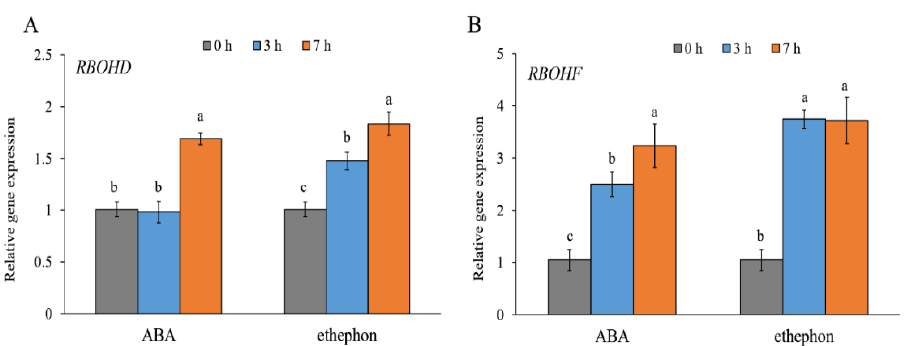
Figure 3. Gene expression patterns of RBOHD ( A ) and RBOHF ( B ) in E. salsugineum leaves sprayed with ABA or ethephon. Data represent mean ± SE ( n = 3). Different letters illustrate significant differences at p ≤ 0.05.